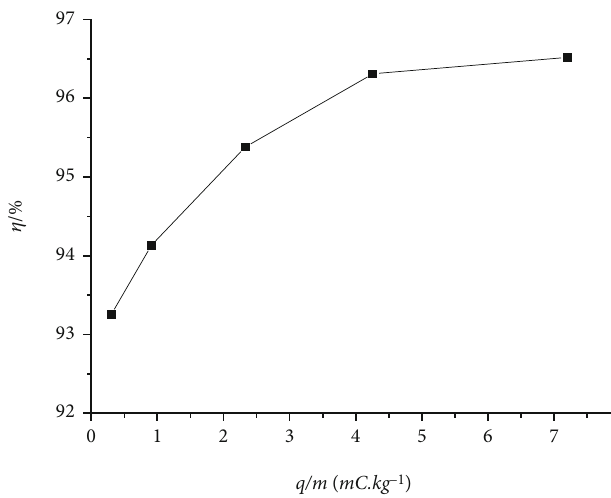
Figure 14: In fl uence curve of charge-mass ratio of water mist on dust removal e ffi ciency.